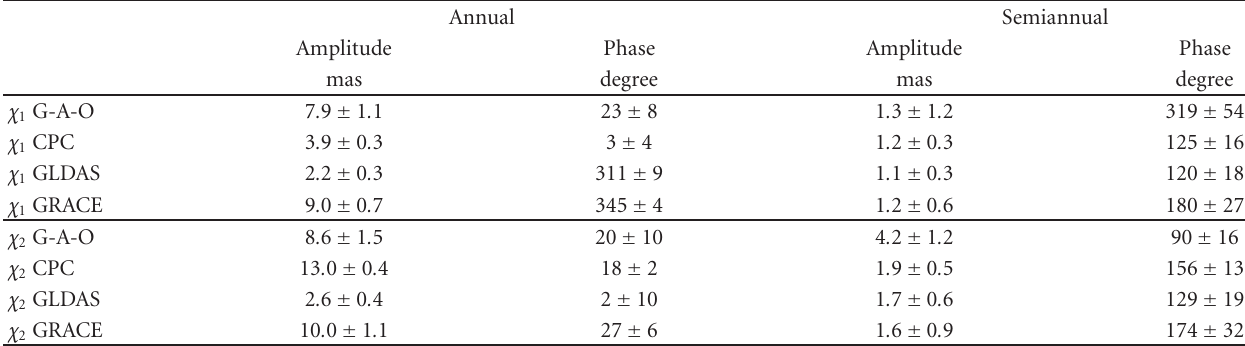
Table 1: Amplitude and phase of seasonal variations estimated from geodetic residuals (G-A-O), GRACE, CPC, and GLDAS-based excitations. For the annual variations, we note that GRACE-based excitation reach a better agreement in amplitude with geodetic residuals than the models.